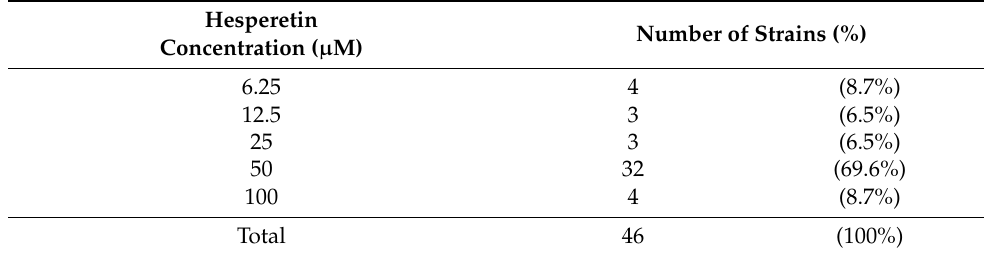
Table 1. MICs of hesperetin against H. pylori clinical isolates.